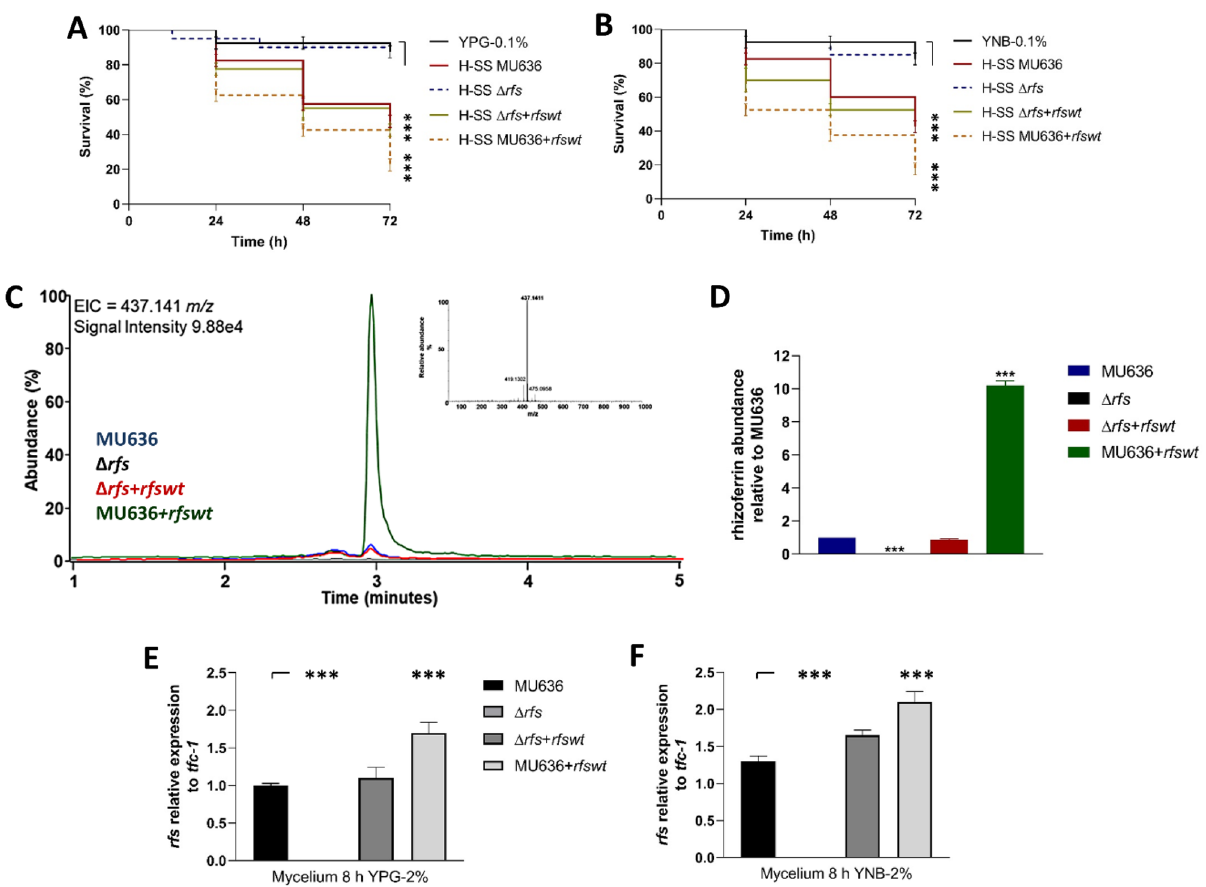
Figure 4. rfs is essential for the toxicity of the cell-free supernatant of the culture (SS) of M. lusitanicus . The toxicity of the SSs obtained from the different strains after 48 h of aerobic growth (H-SS) in ( A ) YPG medium (YPG-0.1%) and ( B ) YNB medium (YNB-0.1%) supplemented with 0.1% glucose was assessed against the nematode. A total of 15–20 nematodes were used per experiment and incubated at 18 °C for 72 h. The results presented are the average of results obtained from four independent experiments. Data were statistically analyzed using the Mantel-Cox test. *** P < 0.01. When results were not considered significant, we did not provide an additional indication ( P < 0.1). ( C ) Extracted ion chromatograms of rhizoferrin ( m/z = 437.141) in SS obtained from the different M. lusitanicus strains after 48 h of growth in the YNB medium with 0.1% glucose. Chromatograms show the relative abundance of the most intense sample. Top, a representative mass spectrum of rhizoferrin. ( D ) Relative abundance of rhizoferrin in the corresponding SS from the different strains. Total RNA was obtained from mycelium grown for 8 h either in ( E ) YPG medium (with 2% glucose) or ( E ) YNB medium (with 2% glucose), and rfs expression was assayed by RT-qPCR. A ∆Ct analysis was performed to compare the mRNA levels between samples, using tfc1 as reference housekeeping gene. Significance testing was performed using ANOVA with Fisher’s exact test, * P < 0.05; ** P < 0.01; *** P <